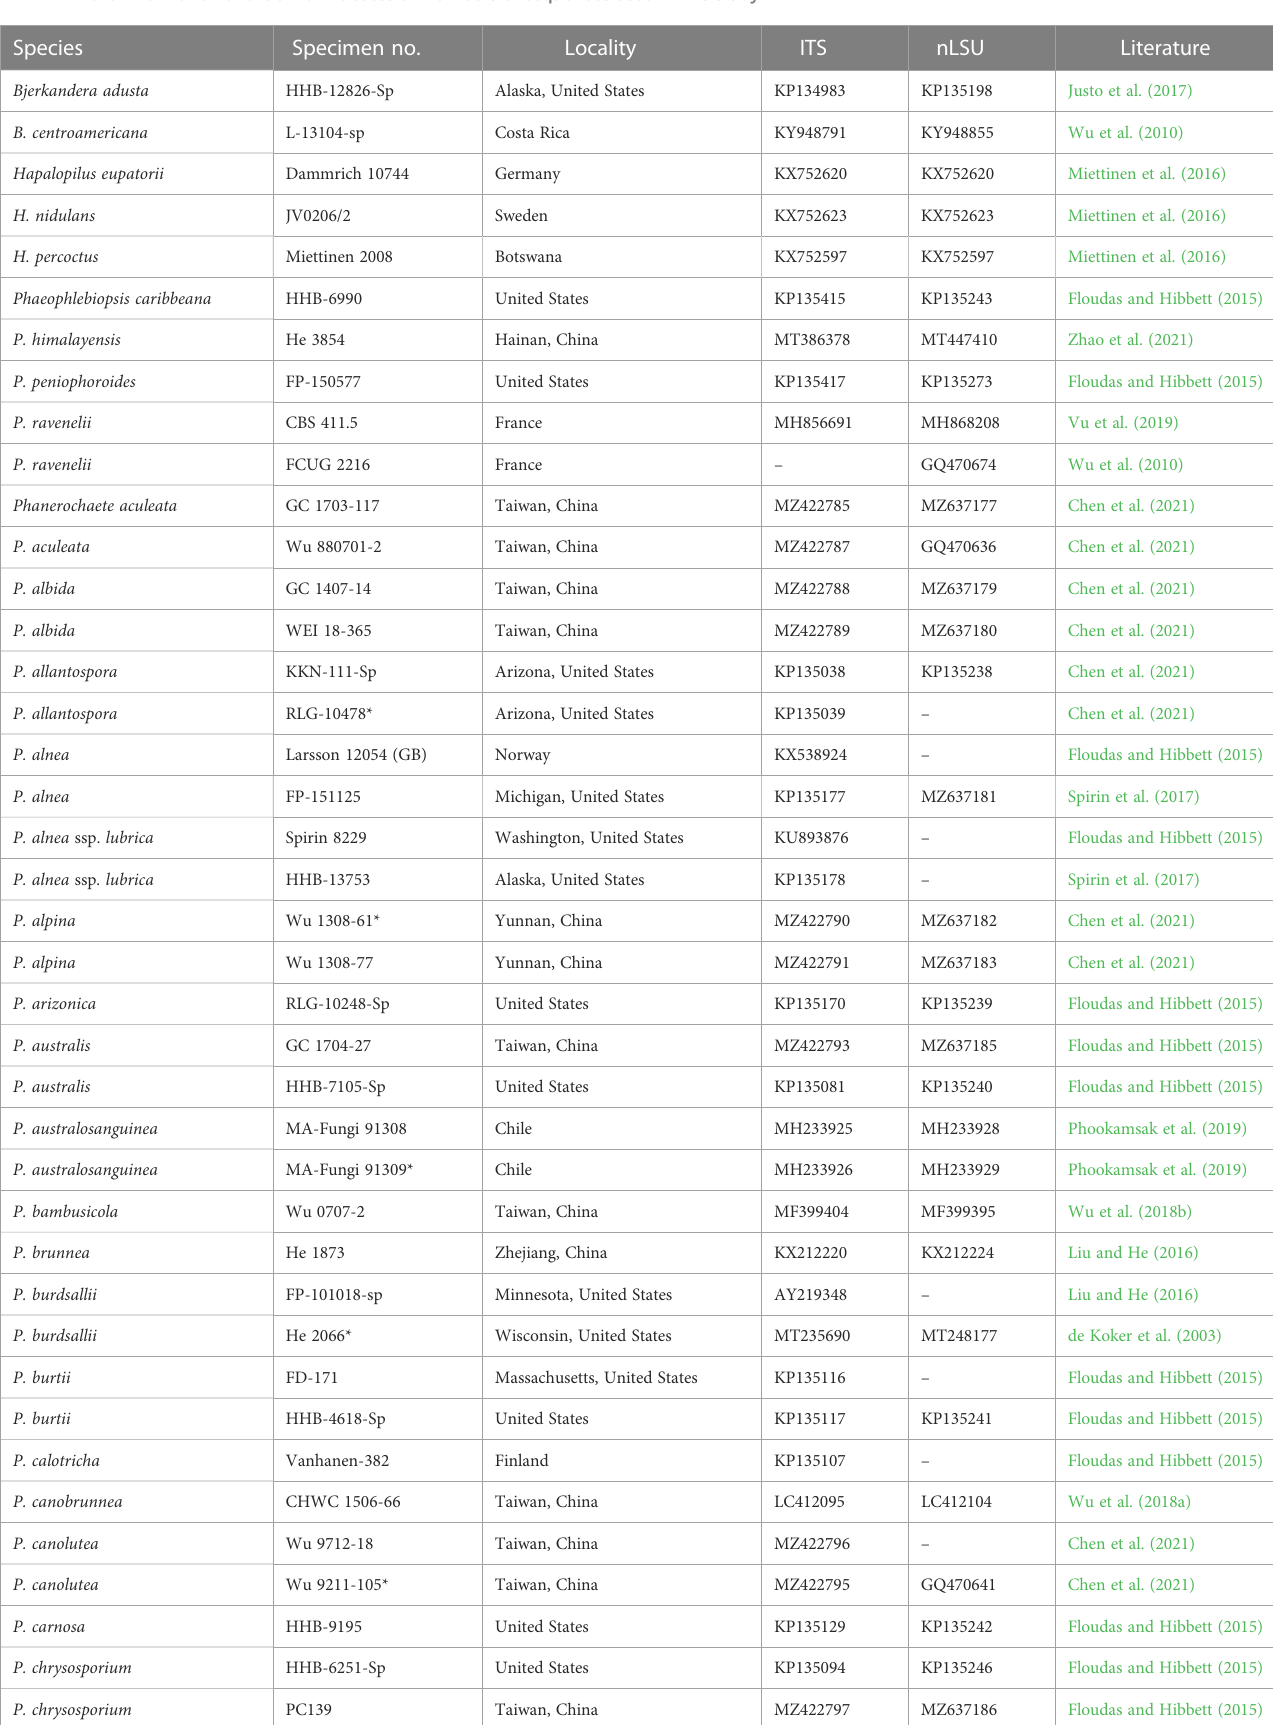
TABLE 1 Taxa information and GenBank accession numbers of sequences used in this